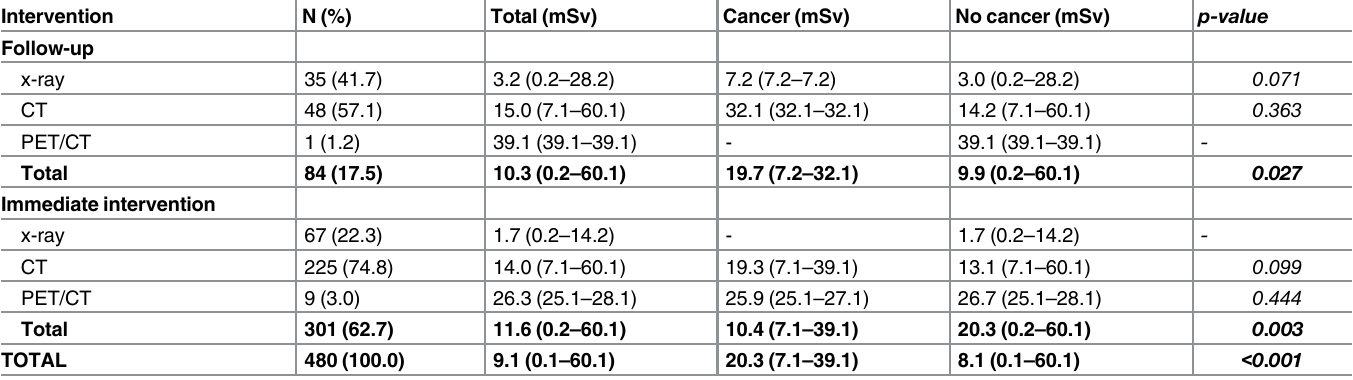
Table 4. Analysis of the radiation exposure (mean, minimum, maximum) associated with the management of SPN for chest radiograph according to the management strategy and for patients with a final diagnosis of lung cancer and those without it. Intervention